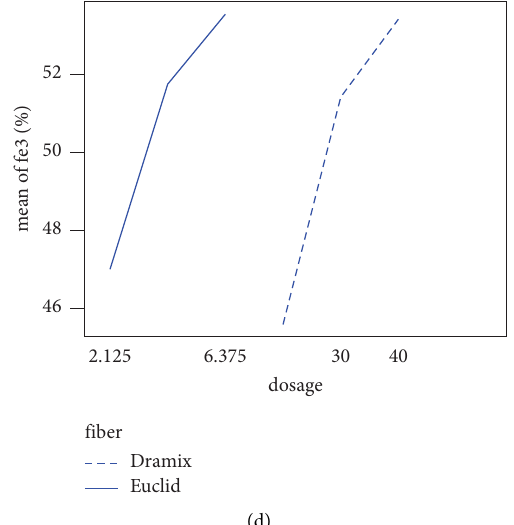
Figure 10: Interaction graphs according to the doses of the fbers. (a) Compressive strength. (b) Modulus of elasticity. (c) Poisson’s ratio. (d) Residual strength.